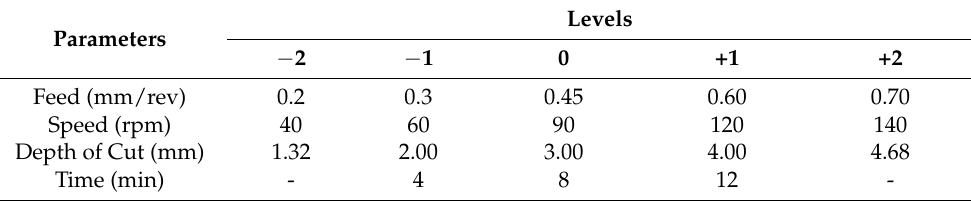
Table 3. Parameters with levels based on the preliminary experimentation.